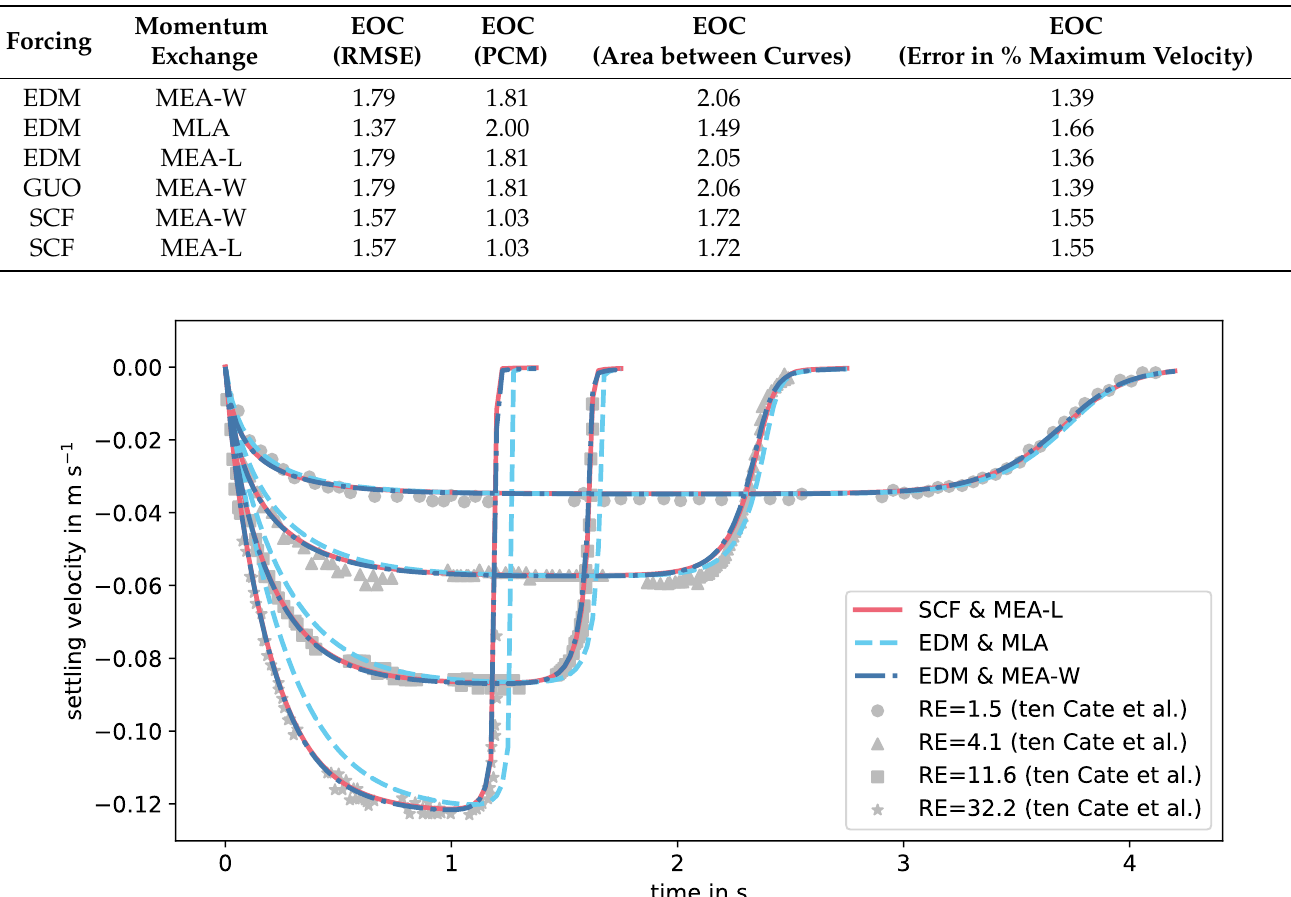
Table 5. Mean experimental order of convergence (EOC) for different error and similarity measures regarding N = 8. Results are averaged over all values for a given combination of forcing and momentum exchange scheme as well as all cases.